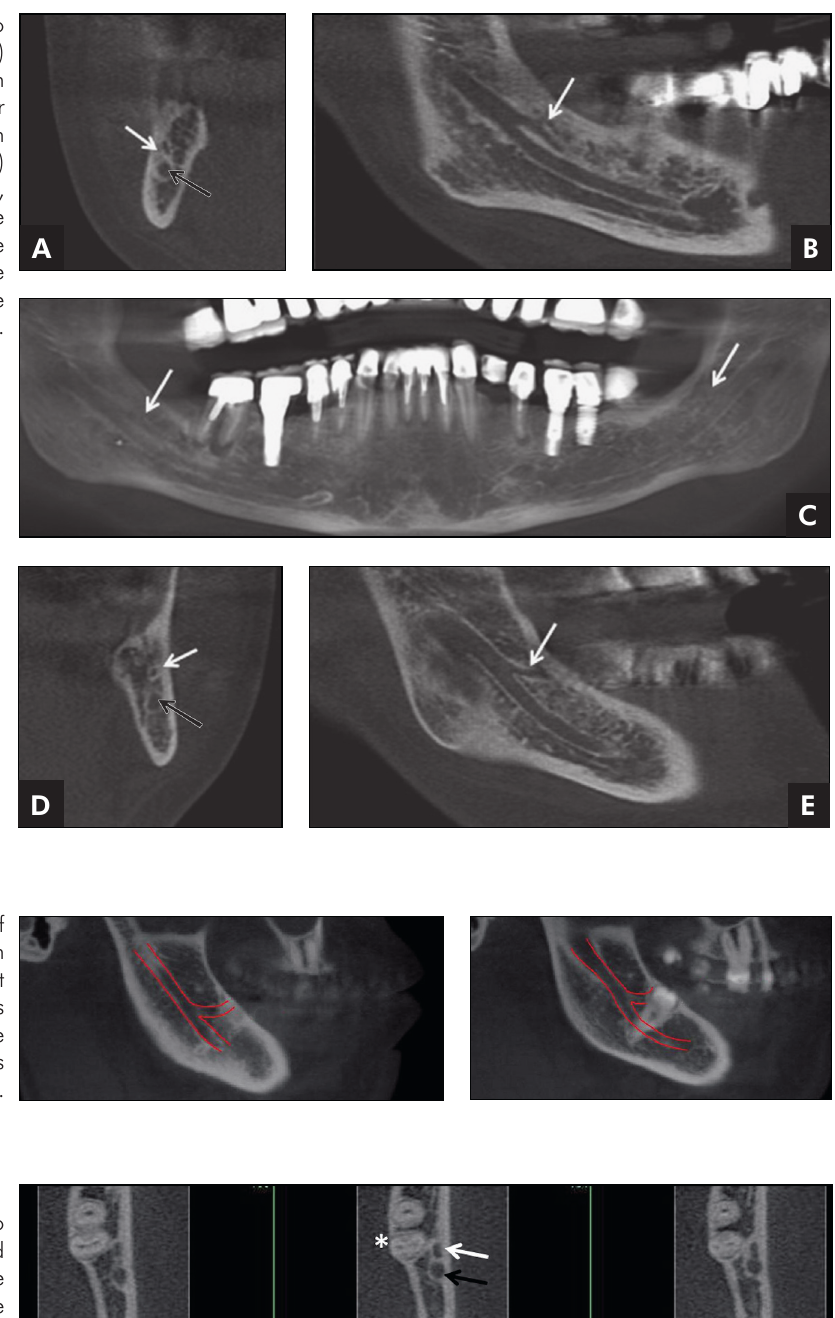
Figure 6 - Transaxial cuts of Type 1 mandibular canal bifurcation close to the roots of the left mandibular third molar. The white arrow indicates the bifurcation and the black arrow, the mandibular canal. The asterisk (*) indicates the third molar roots.